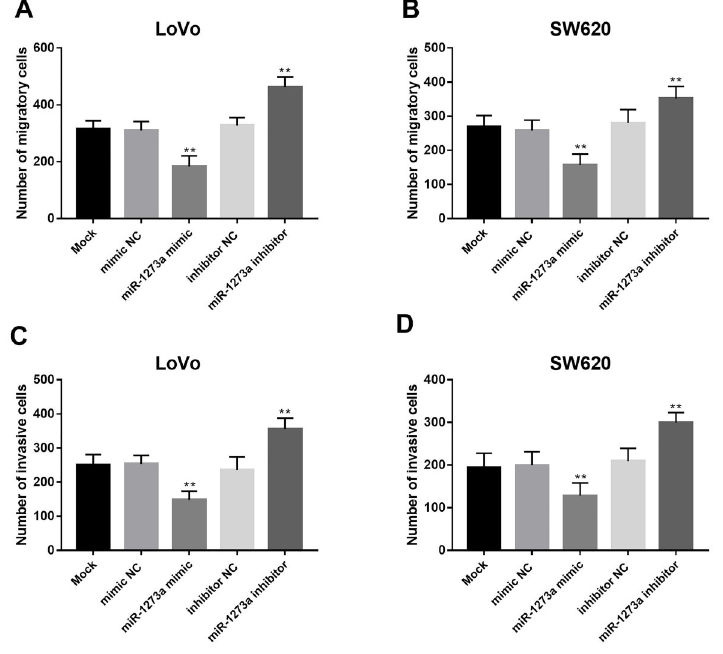
Figure 4. A and B , The upregulation of miR-1273a suppressed, whereas the downregulation of miR-1273a promoted, the migration of colon cancer cells. C and D , Similarly, the invasion of colon cancer cells was suppressed by miR-1273a upregulation, whereas it was promoted by miR-1273a downregulation. Data are reported as means ± SD. **P o 0.01 (ANOVA followed by Tukey ’ s